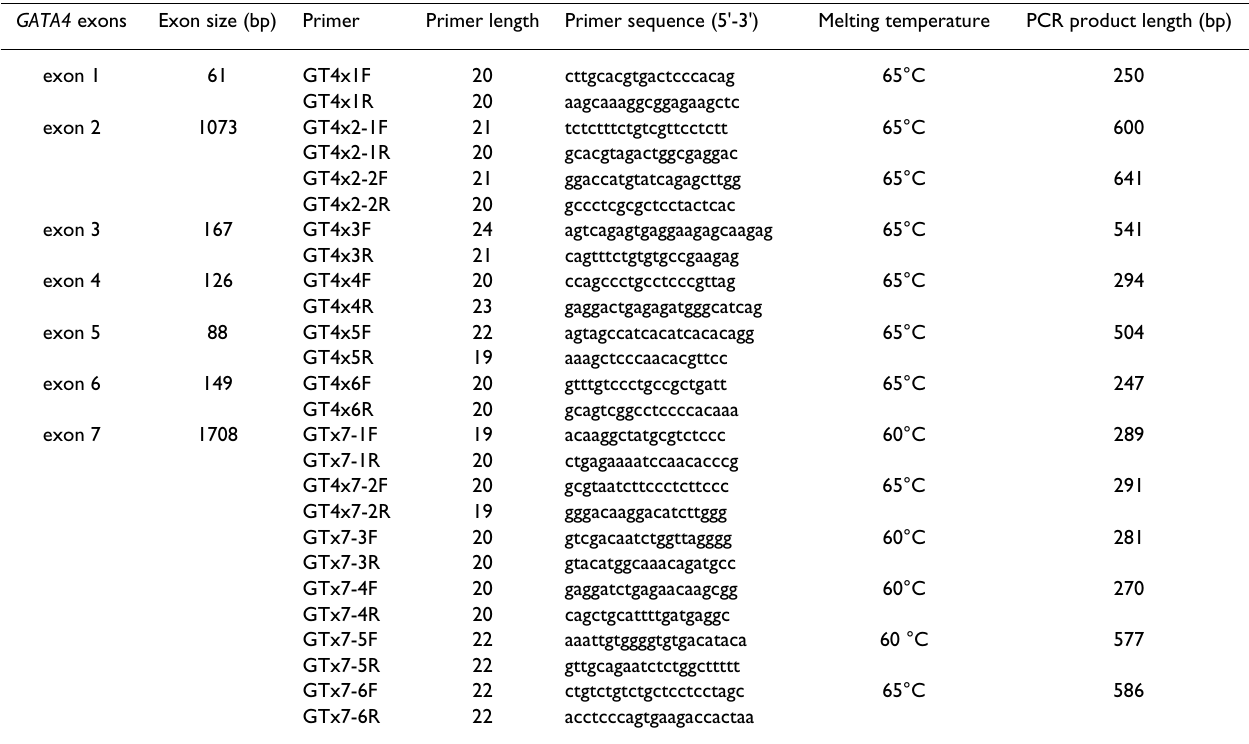
Table 1: Primer sequences and PCR conditions used for analysis of GATA4 mutations GATA4